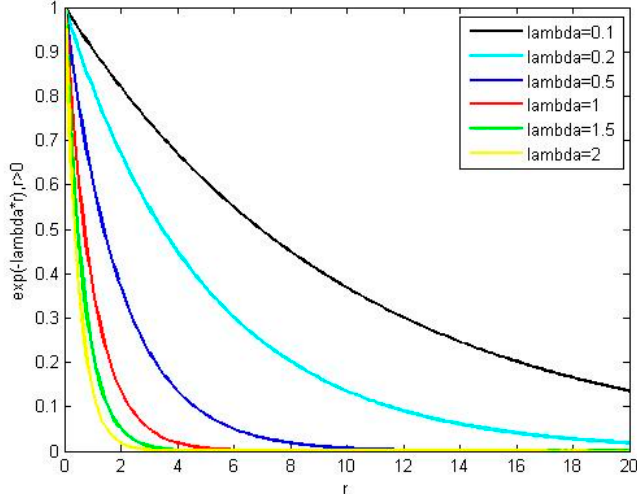
λ . Figure 1. Shape of exponential function with different parameter λ